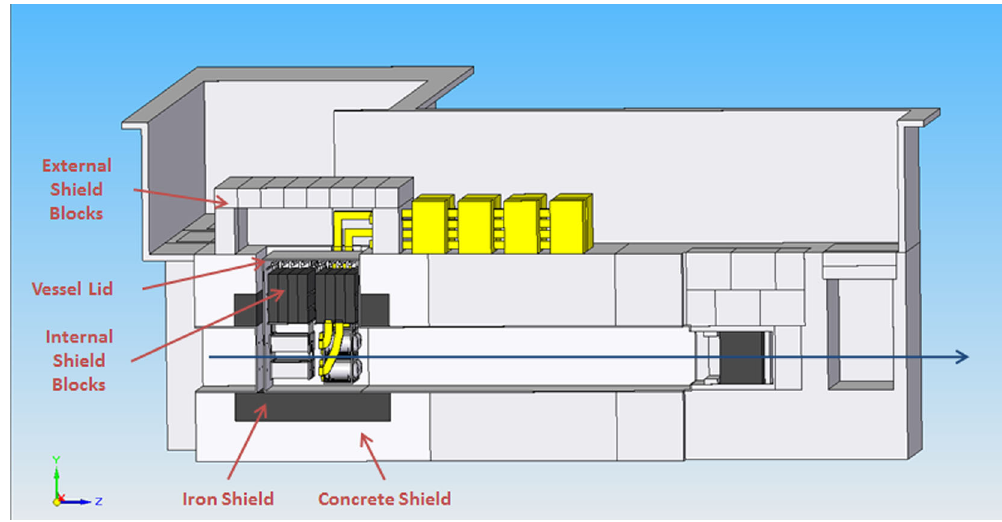
FIG. 12. Beam line